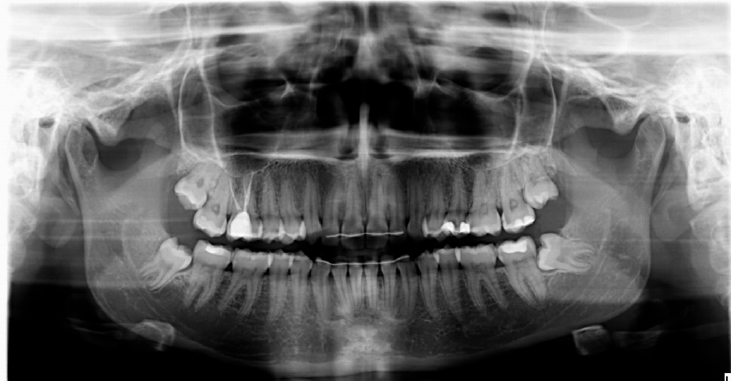
Figure 3. Pre-operative panoramic radiograph.